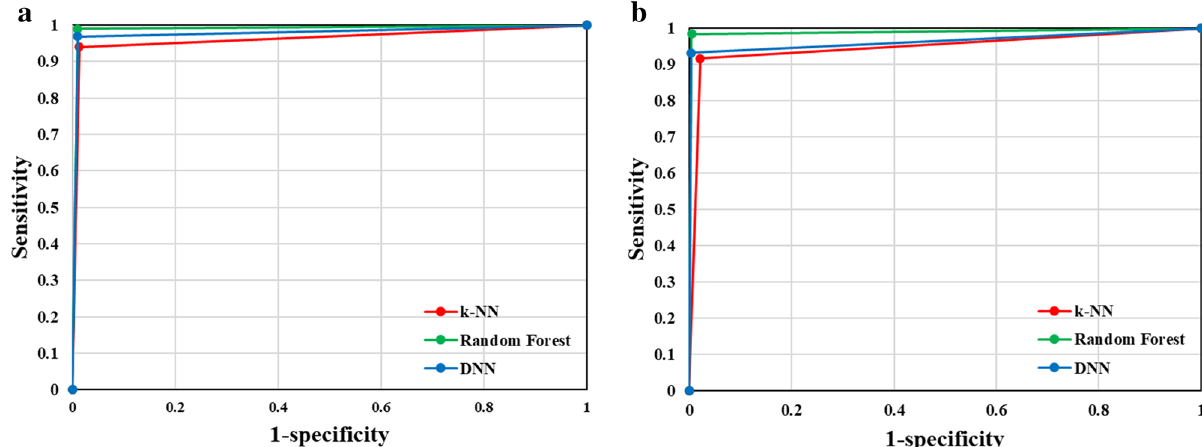
Figure 5. AUC graphs for psoriasis severity classification performance of k-NN, RF, and DNN model for different combinations of features or datasets. The three classifiers were commonly trained using a combination of texture and color features: (a) used only dataset B, and (b) used a new dataset B, including patch